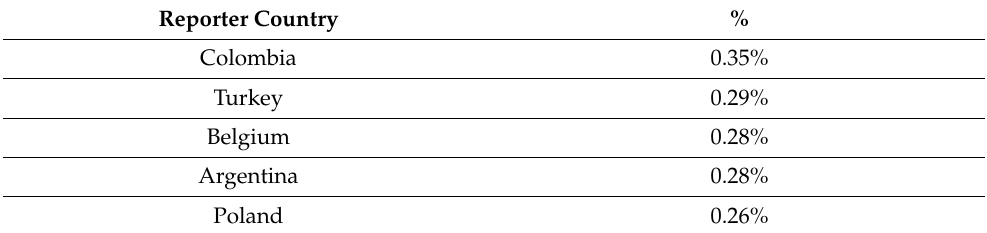
Table 1. Cont. Reporter